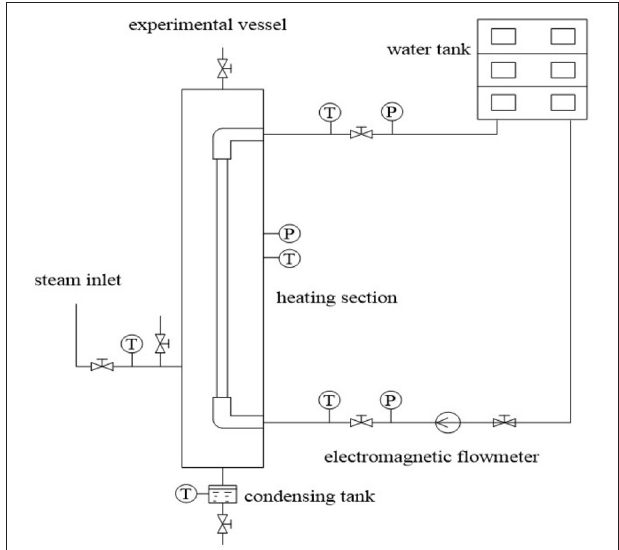
FIGURE 1 | Diagram of the experimental